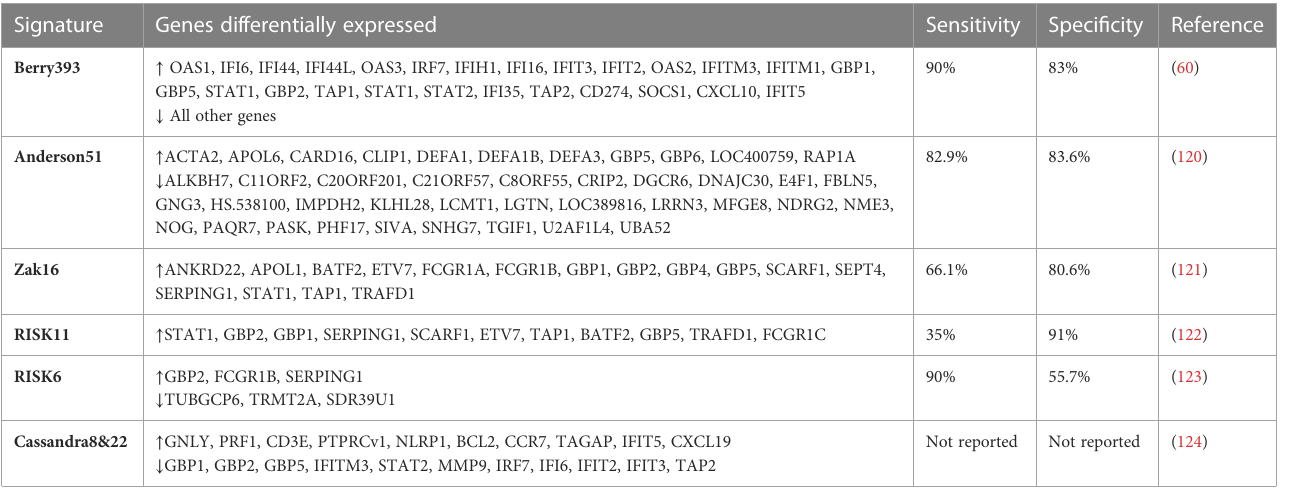
TABLE 2 Genes associated with TB disease risk, and in the context of